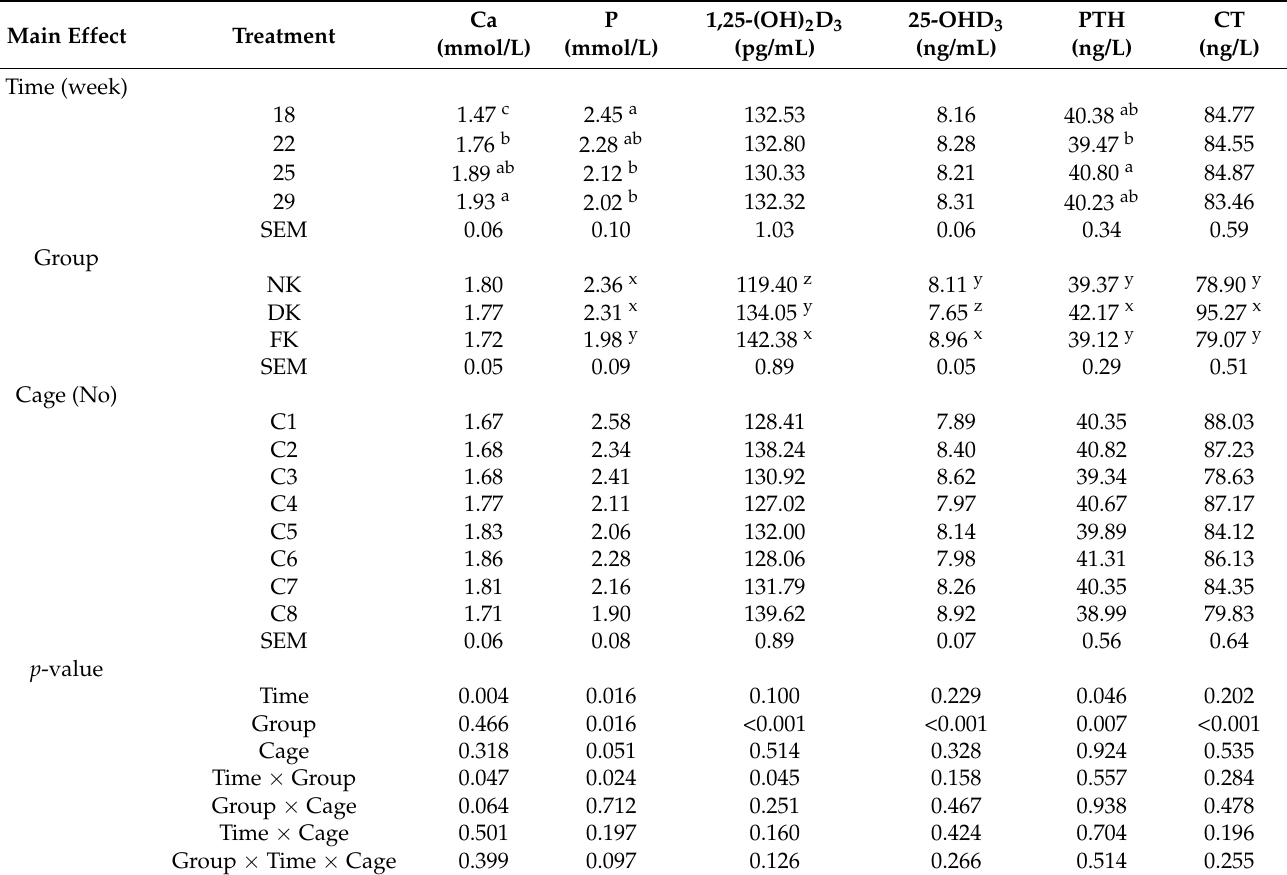
Table 4. Measurement of serum Ca and P metabolism-related markers in laying